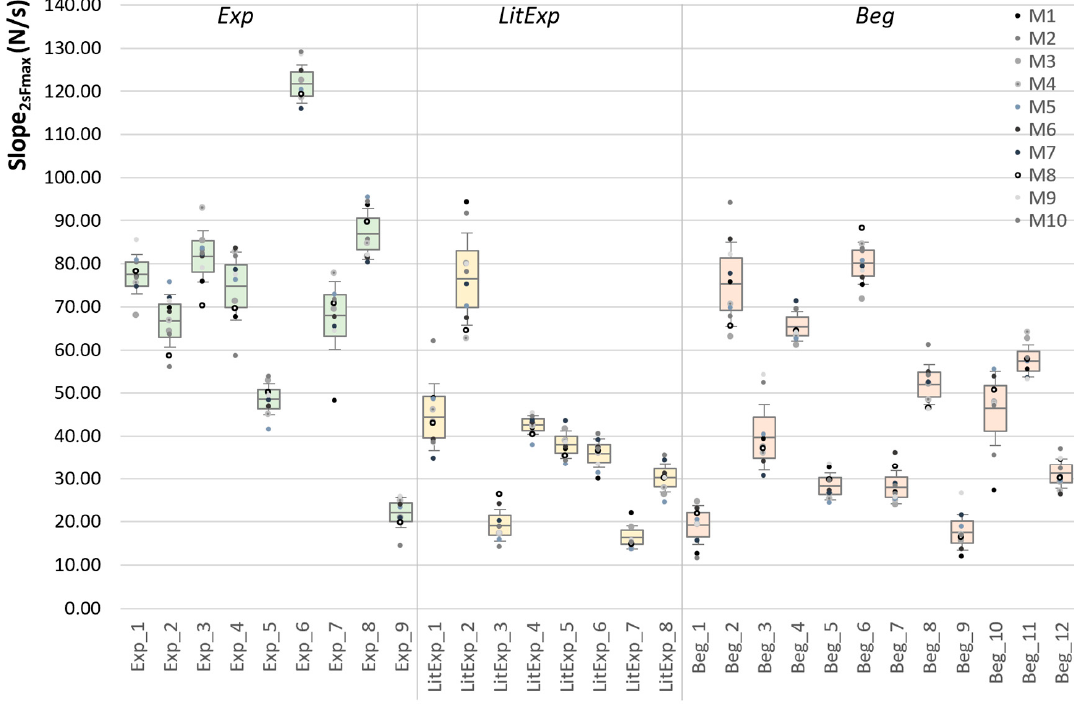
Figure 7. Overall Slope. Displayed are the arithmetic means (M), 95% confidence intervals (CI) and standard deviations (SD; error bars) of the slope_2max (N/s) of the 10 trials of each tester sorted into groups experienced (Exp; green, n = 9), little experienced (LitExp; yellow, n = 8) and beginners (Beg; orange, n = 12). Table 2. Intraindividual slope in the linear section. Results of statistical tests (RM ANOVA for Exp and LitExp; Friedman test for Beg) analyzing the slope in the linear section XYZ between the 10 repetitions within each group Exp, LitExp and Beg, respectively. Given are the test statistics F or χ 2 , significance p and effect size η 2 for RM ANOVA.